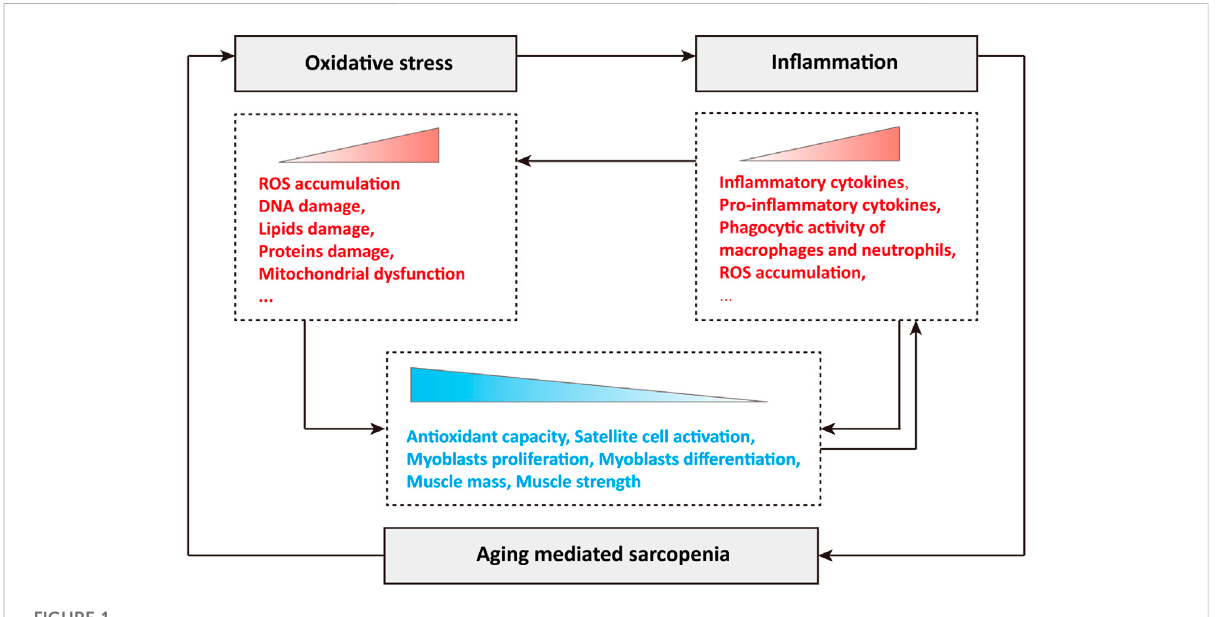
FIGURE 1 Relationship among oxidative stress, in fl ammation and sarcopenia during